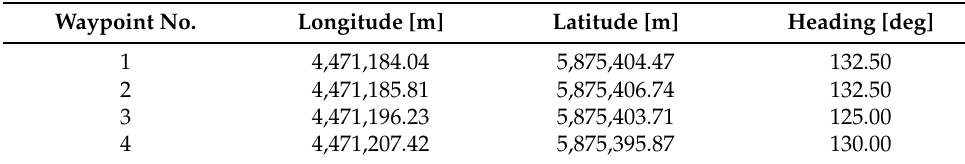
Table 2. Departure maneuver waypoints (WPTs) data.